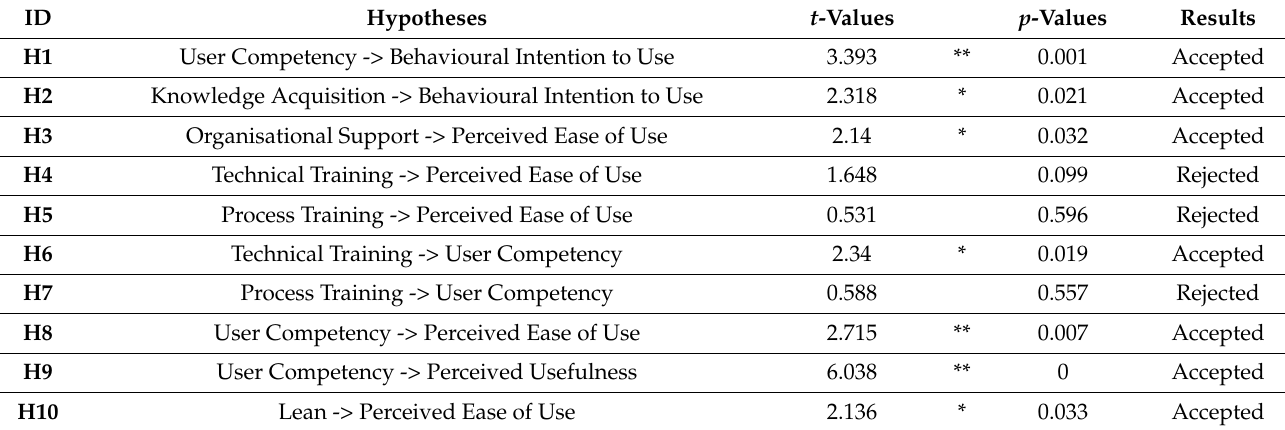
Table 6. Significance and hypotheses testing results.